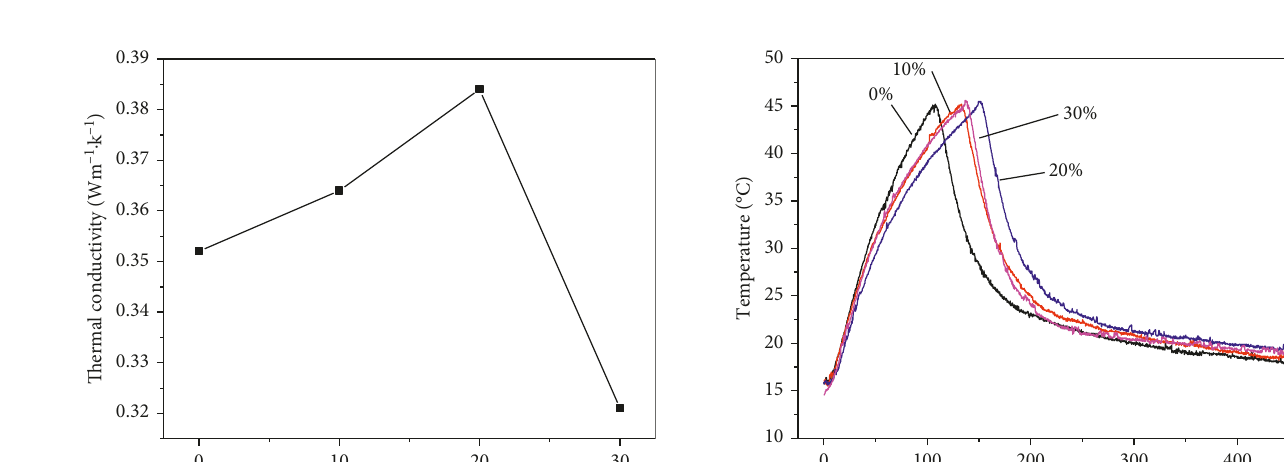
Figure 4: Mechanical properties of gypsum boards with OD/EP.